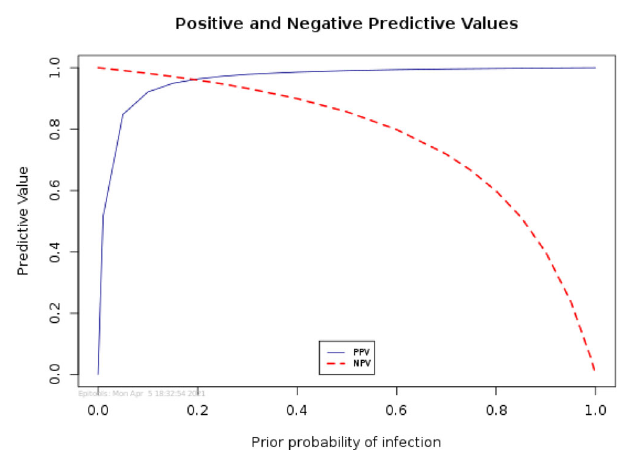
Fig. 1 Positive and negative predictive values for the detection dogs ’ olfaction test (K9 test) using RT-PCR test as the gold standard. There is a reciprocal variability relationship between PPV and NPV of K9 test at different prior probabilities of infection.